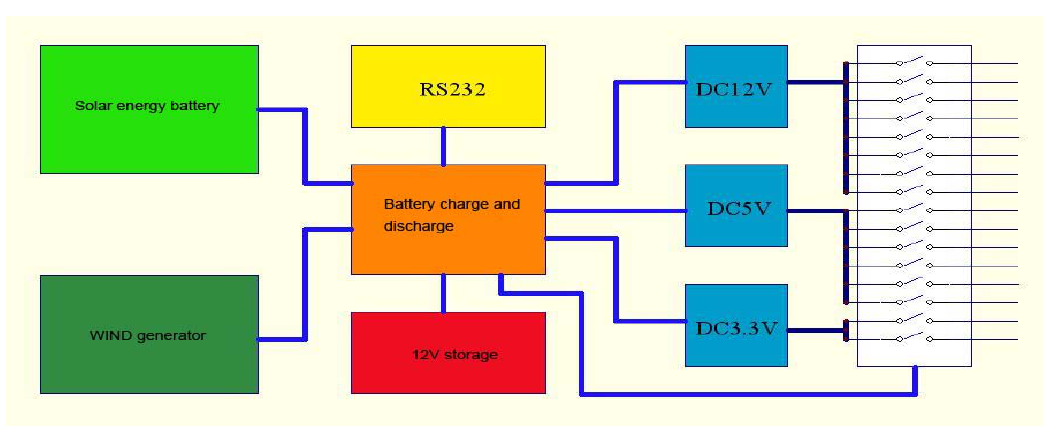
Figure 11. Embedded intelligent power management